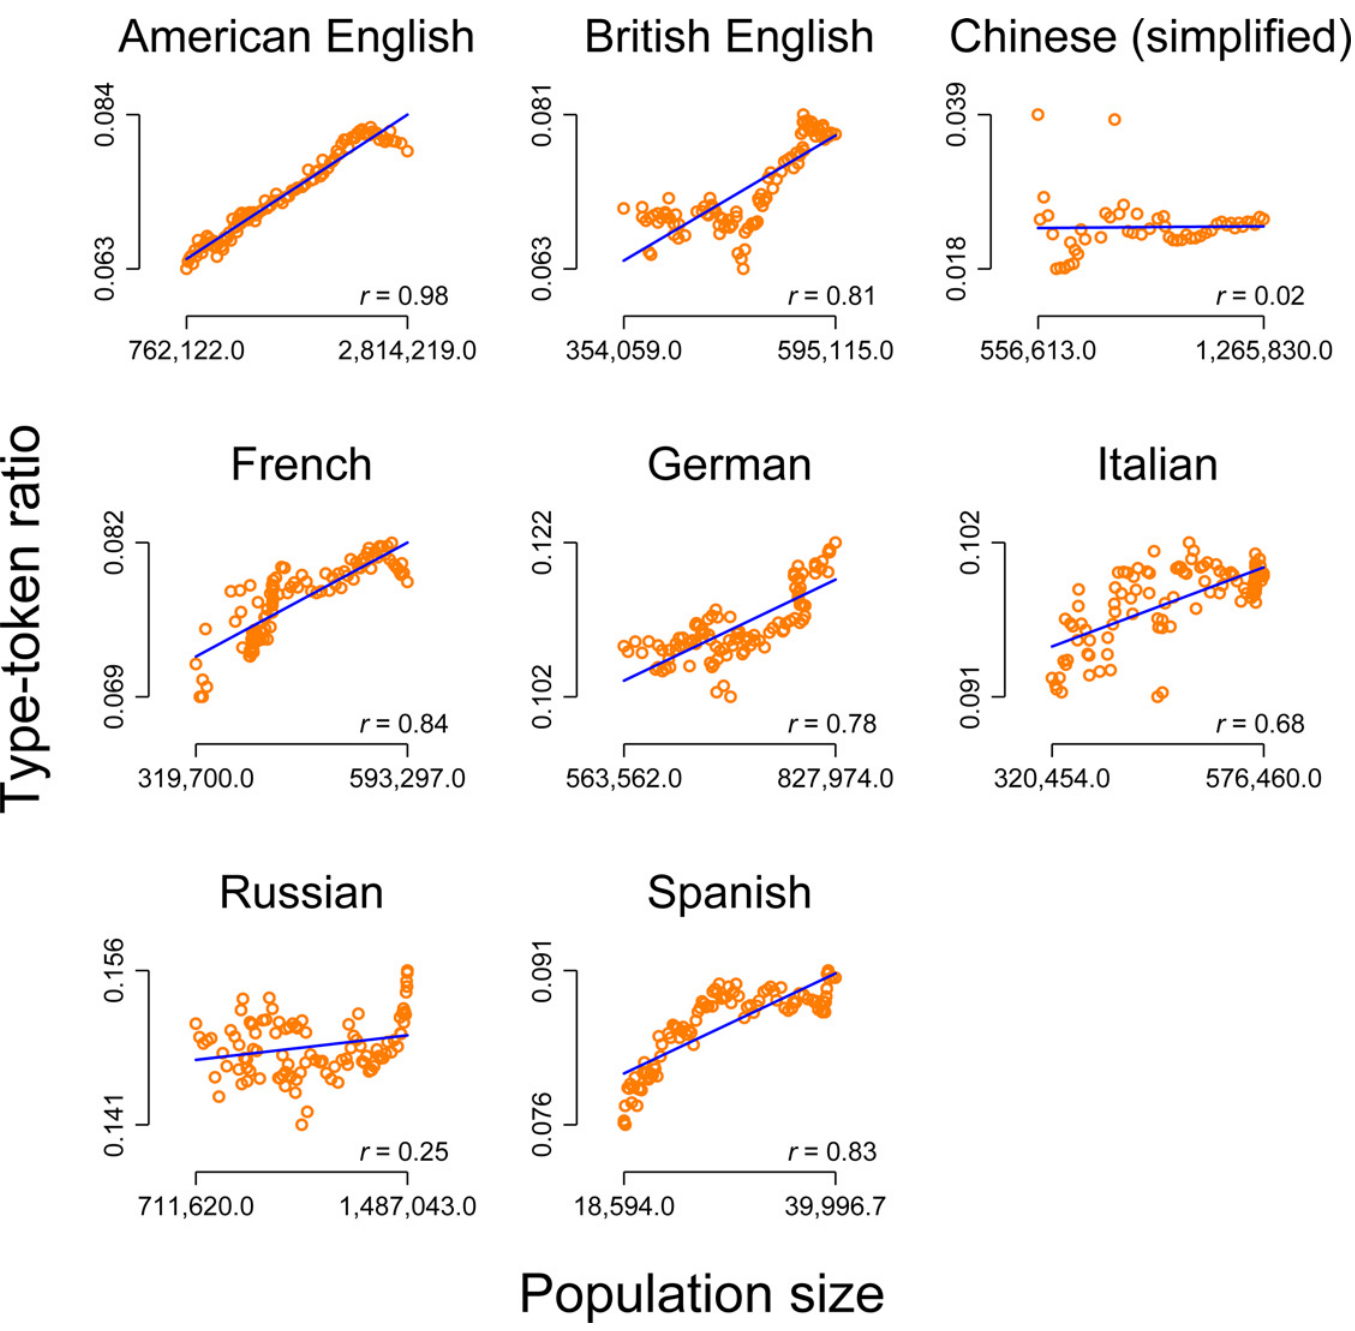
Fig 1. Correlation between the level of the population size and the level of the type-token ratio for eight languages (including two varieties of English). Orange circles: raw data. Blue line: linear prediction of the type-token ratio on the population size. Notes on the bottom right: Pearson correlation (all p s < .05 or better, except for Chinese where p =